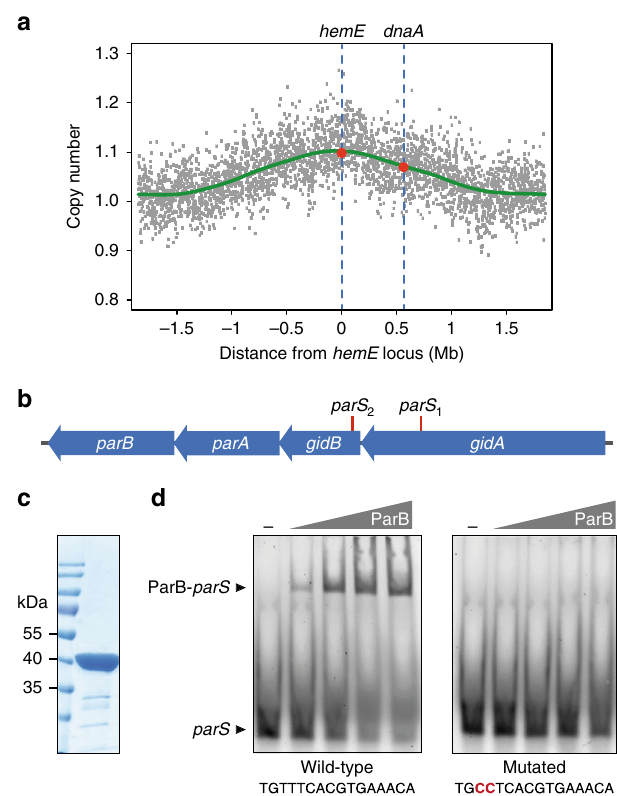
Fig. 1 Characterization of the chromosomal ori region of H. neptunium . a Location of the chromosomal replication origin. The plot shows the relative abundance of chromosomal loci in growing H. neptunium wild-type cells, as determined by sequencing-based marker frequency analysis. The green line indicates the average of the data points. The values obtained for the hemE and dnaA loci are indicated by red dots. b Schematic representation of the parAB locus. The positions of the two parS sites identi fi ed in the H. neptunium genome sequence are indicated. c Purity of the ParB preparation used in the binding assay. Puri fi ed ParB-His 6 (10 µ g) was subjected to SDS-PAGE and stained with Coomassie blue. A molecular weight standard is shown for comparison. d Interaction of ParB with its parS target sequence. Cy3-labeled double-stranded DNA oligonucleotides (10 nM) carrying the wild-type (left) or a mutated (right) parS sequence, respectively, were incubated with increasing concentrations of ParB-His 6 (0, 0.05, 0.1, 0.3, and 0.6 µ M). Nucleoprotein complexes were separated from the free oligonucleotides by PAGE and visualized by fl uorescence imaging. Red letters indicate substitutions in the parS